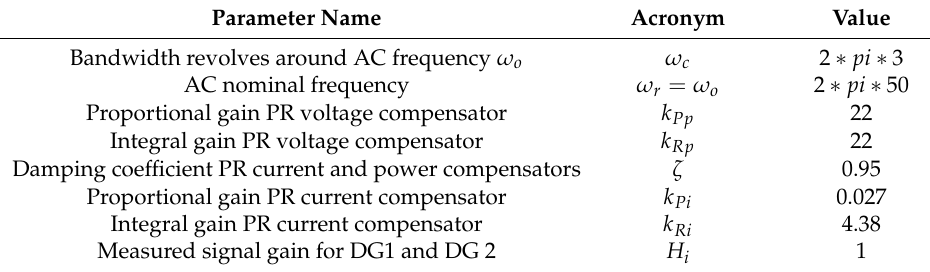
Table 2. The control parameters of the inverters.